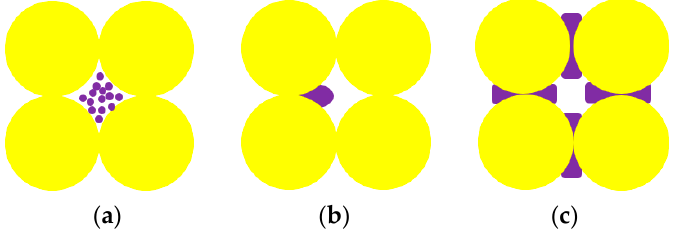
Figure 1. Cementation types of hydrate sediments: ( a ) padding, ( b ) skeleton, ( c ) cement. (Adapted with permission from Ref. [17]. 2010, Brugada. J., Cheng, Y.P., Soga, K).